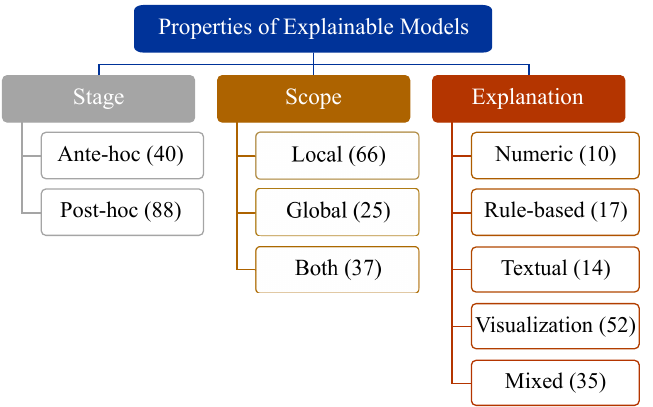
Figure 11. Distribution of the selected articles based on the stage, scope, and form of explanations. The number of articles with each of the properties is given in